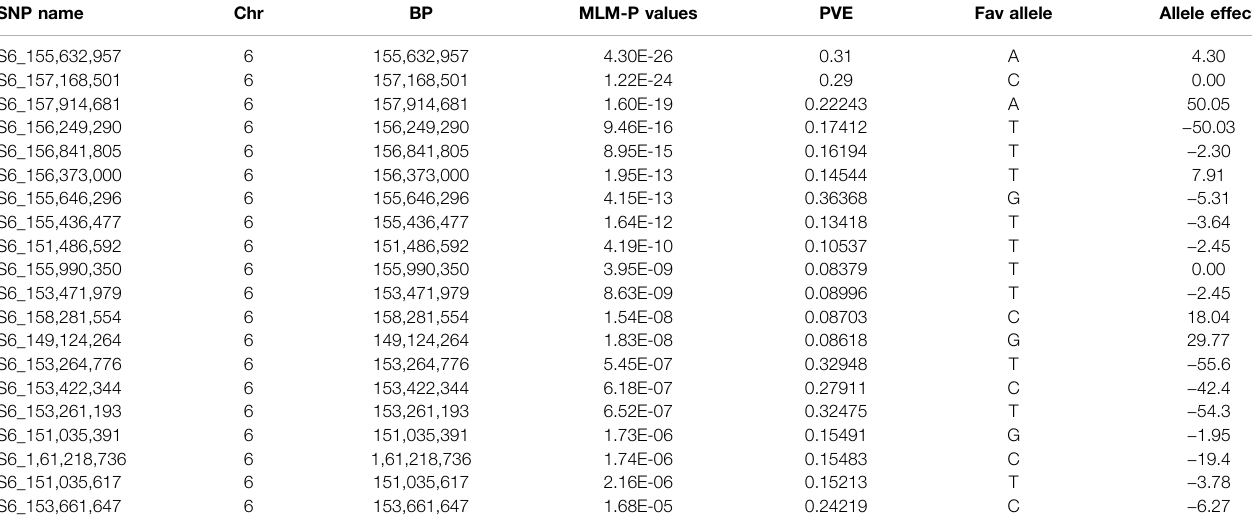
TABLE 6| Chromosomal positions and SNPs signi fi cantly associated with both MLN disease severity (DS) and area under the disease progress curve (AUDPC) and used in validation